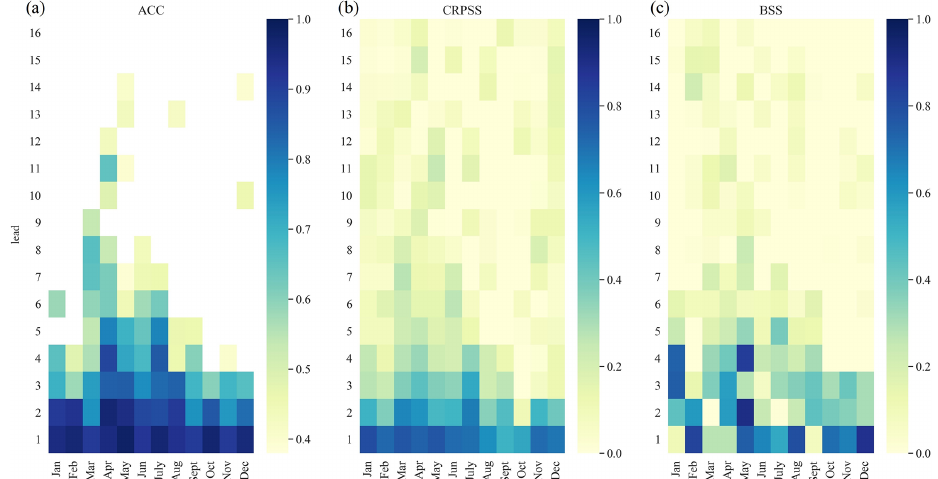
Figure B4. Overview of the weekly evaluation scores for fresh surface water level hindcasts for different initialization months. (a) ACC, (b) CRPSS, and (c) BSS heatmaps for the example station of Nijmegen.